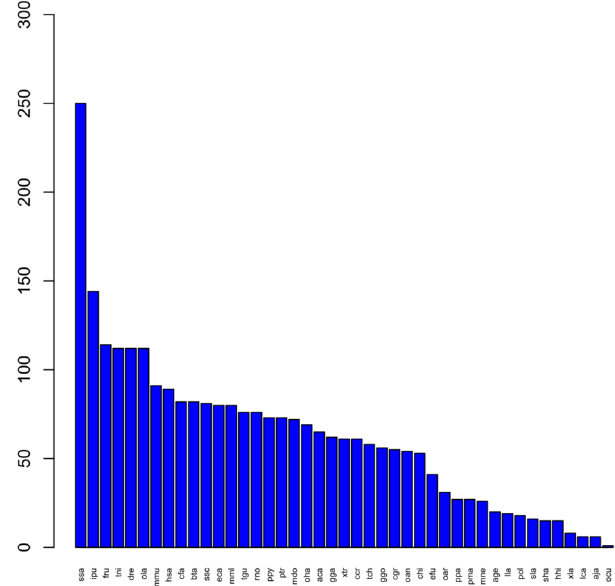
Figure 2. Conservation profiles of the identified GIFT liver miRNAs with miRNAs from other fish species, including Salmo salar (ssa), Ictalurus punctatus (ipu), Fugu rubripes (fru), Tetraodon nigroviridis (tni), Zebrafish (dre), and Oryzias latipes